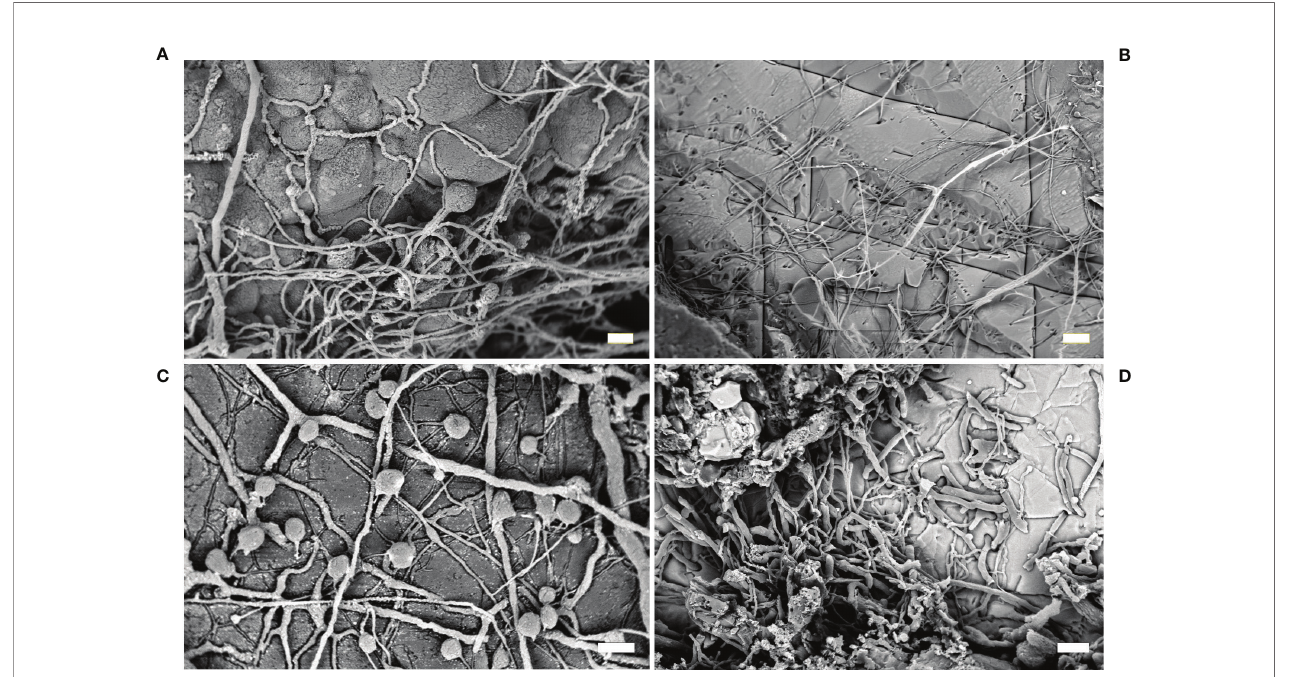
FIGURE 4 | Fungi. (A) Fungi traces with typical thin exploratory hyphae and bag-shaped swellings (SEM image); (B) traces of the ichnospecies Orthogonum fusiferum (SEM image); (C) resin casts of the ichnospecies Saccomorpha sphaerula showing typical globular swellings and fi laments (SEM image); (D) O. fusiferum mixed with other cyanobacterial traces spreading parallel to the substrate surface (SEM image). Scale bars: (A, C) = 10 µm; (B) = 30 µm; (D) = 20